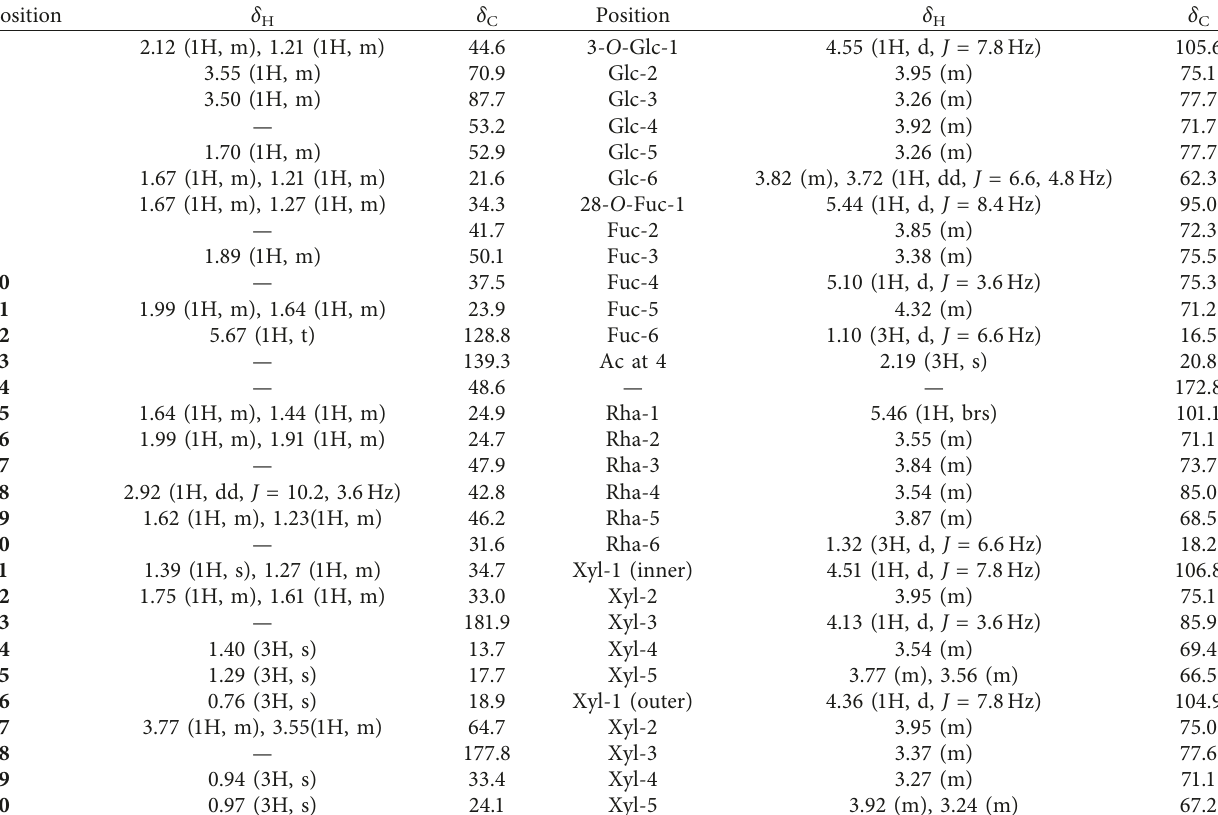
Table 1: The spectral data of 1 H-NMR (400 MHz) and 13 C-NMR (100MHz) of compound 1 in